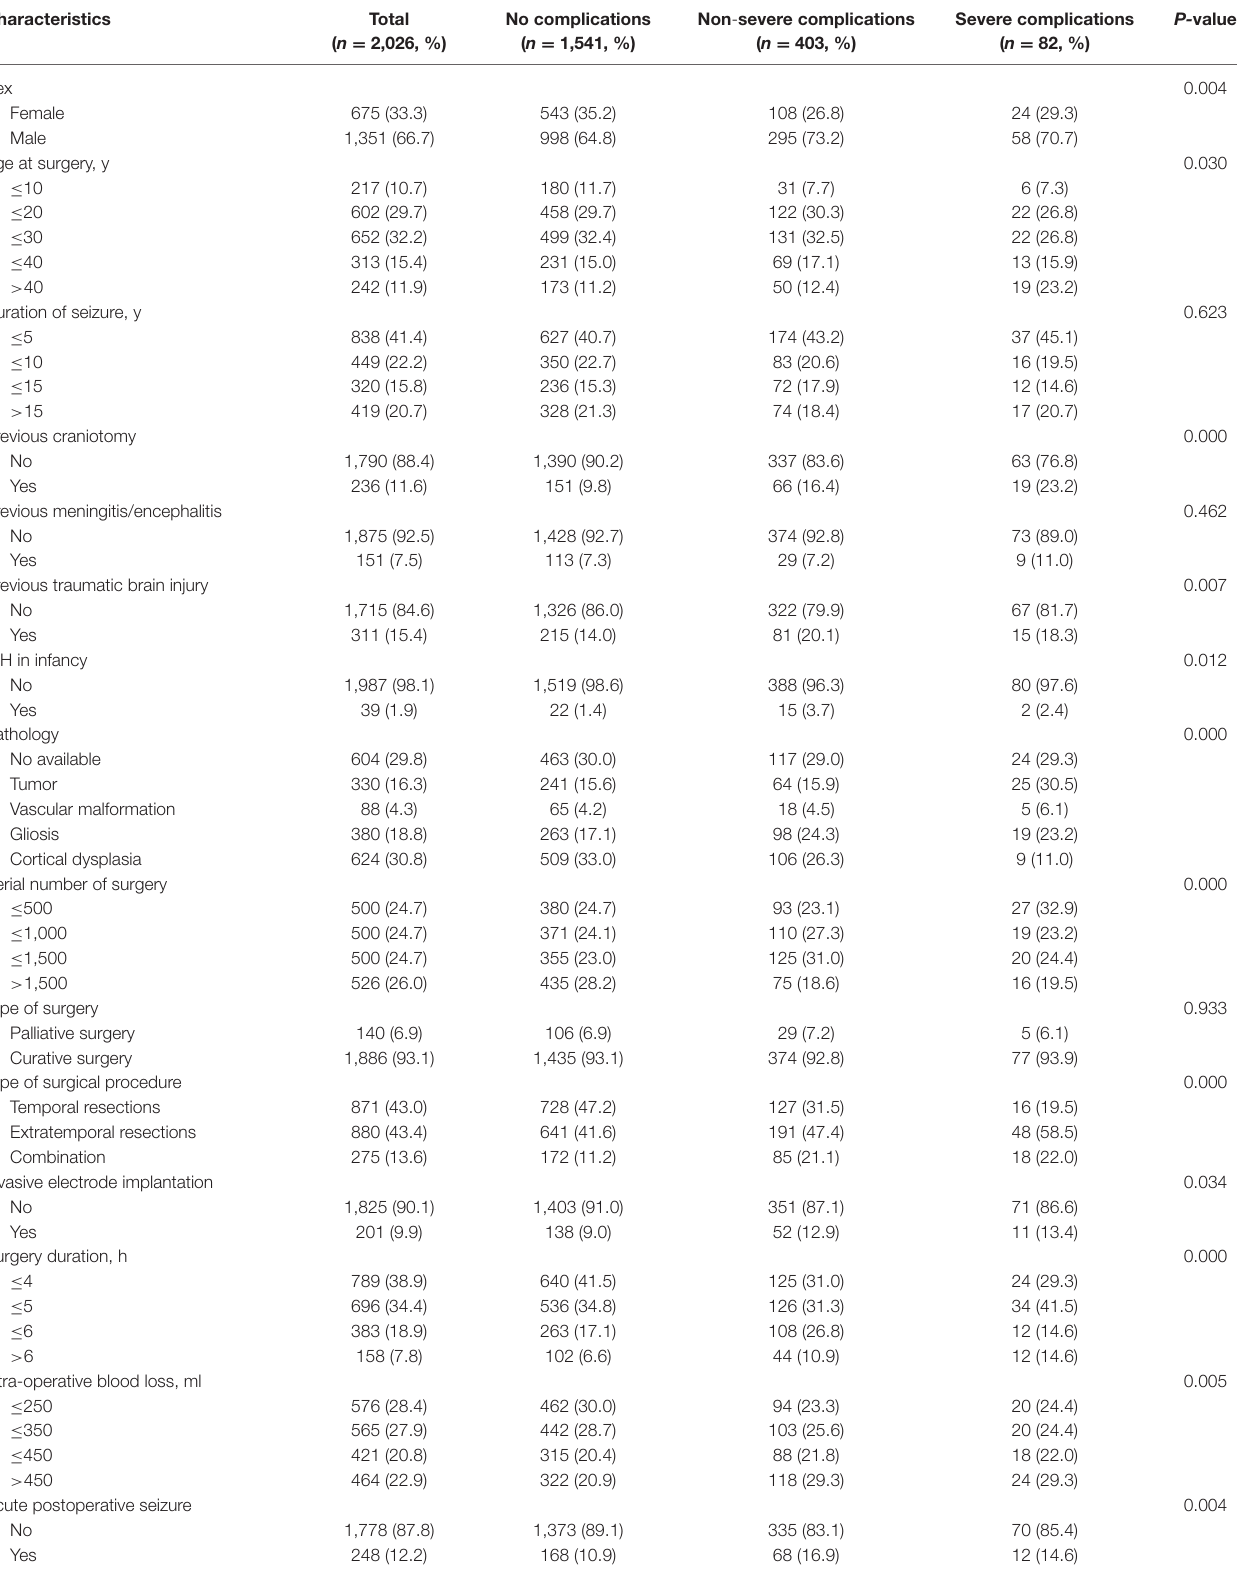
TABLE 3 | Potential factors for complications.